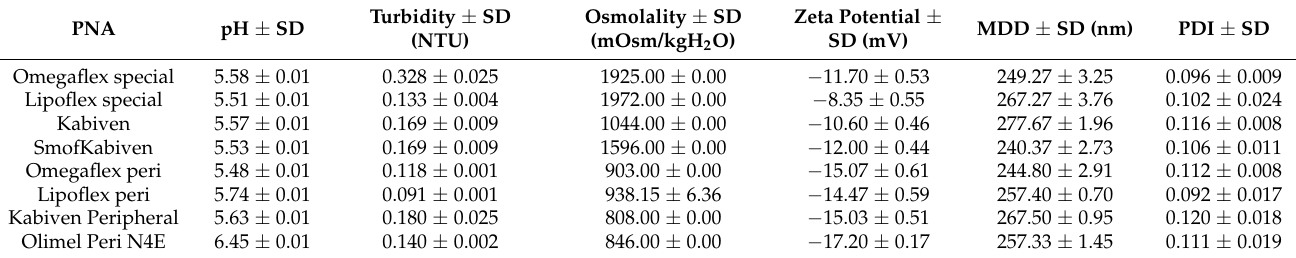
Table 3. Results for RTU-PNAs after activation at 0